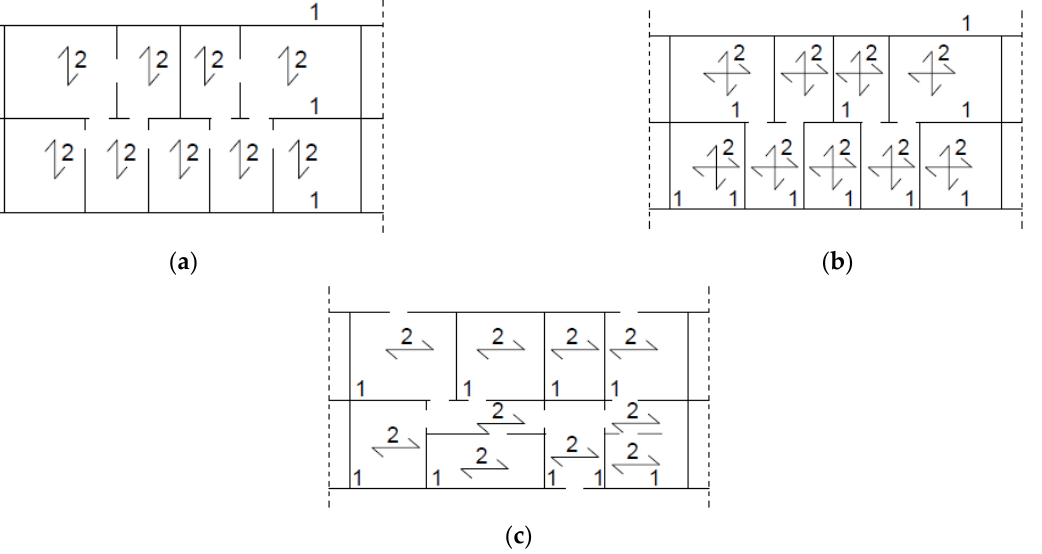
Figure 3. Typical configuration of panels: ( a ) longitudinal ( b ) cross-wall ( c ) transverse, where 1—load bearing walls and 2—direction of floor spans. Table 1. Classification of joints based on their location and construction method (based on the information provided in [11,13]).